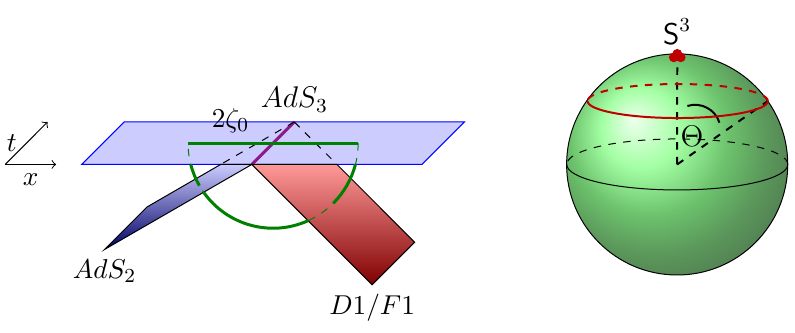
Figure 7 . Entanglement minimal surface (depicted in green) wraps all of S 3 (and T 4 ) and is a geodesic inside AdS 3 anchored at a CFT space interval of size 2 (cid:16) 0